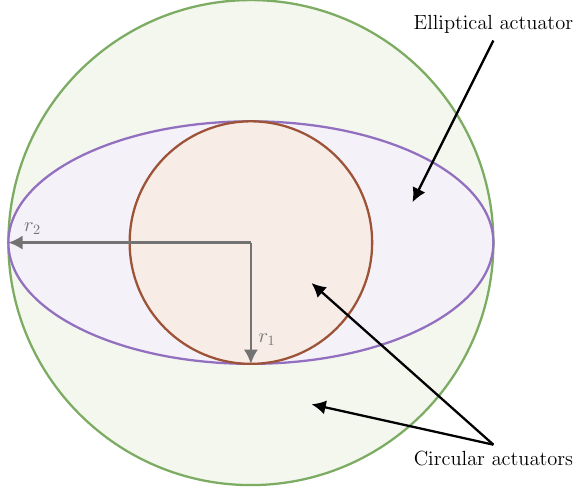
Figure 1. Elliptical DEAP actuator approximated by two circular